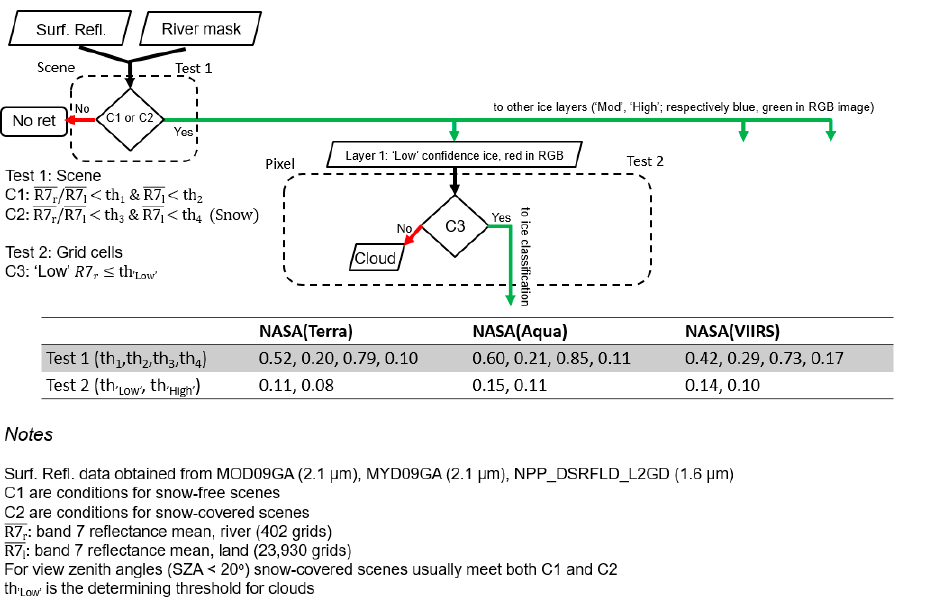
Figure 3. Algorithm flow chart for the cloud identification portion of STC, detailing the tests, conditions and thresholds applied to MODIS and VIIRS surface reflectance data.